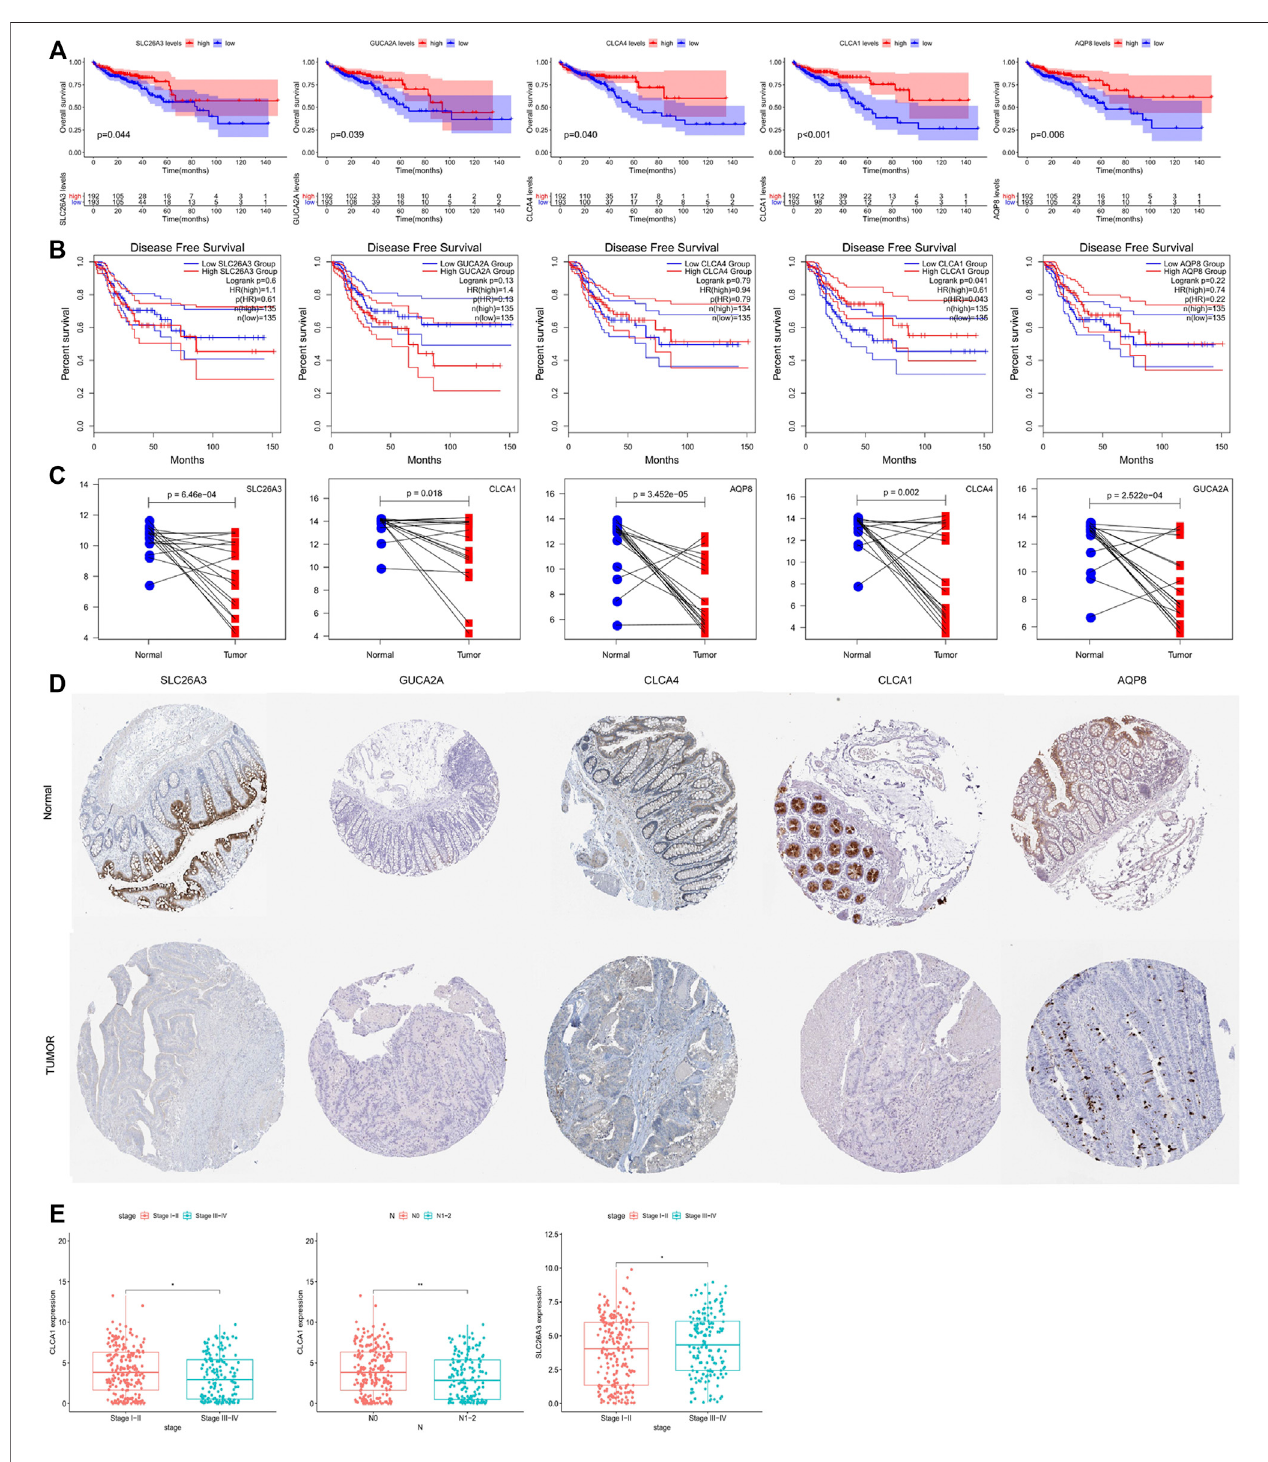
FIGURE 4 | (A) Overall survival (OS) analysis of 10 hub genes in colorectal adenocarcinoma patients by R survival package. Patients were divided into high-level group (red) and low-level group (blue) according to the median. p values < 0.05 were considered to be statistically signi fi cant. (B) Disease-free survival (DFS) analysis of the fi vehubgenes(SLC26A3,GUCA2A,CLCA4,CLCA1,andAQP8)incolorectaladenocarcinomapatientsfromtheGEPIA2database.Patientsweredividedintohigh- level group (red) and low-level group (blue) according to the median. p values < 0.05 were considered to be statistically signi fi cant. (C) Validation of the expression levels of 10 hub genes in colorectal adenocarcinoma patients and normal tissues in the GSE110224 dataset. (D) Expression pro fi les of the four genes in the colorectal adenocarcinoma patients and normal tissue. Images were taken from the Human Protein Atlas (http://www.proteinatlas.org). (E) Correlation analysis between the survival-related genes and clinical factors. p values ≤ 0.05 were considered to be statistically signi fi cant.